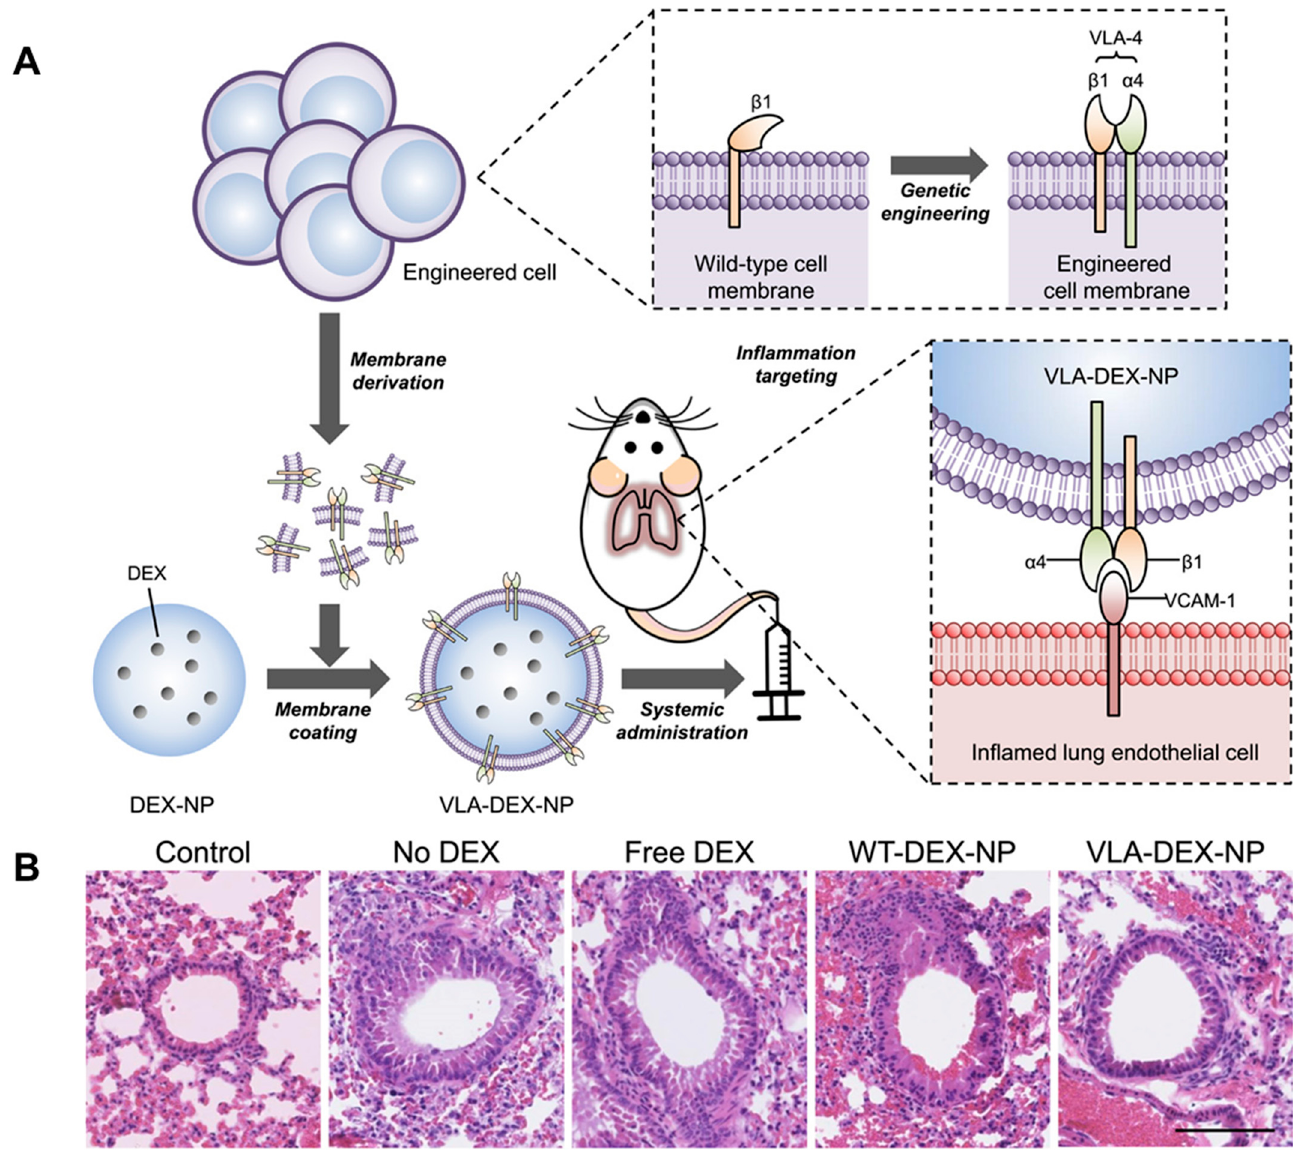
Figure 5. ( A ) Schematic illustration of genetically engineered cell membrane-coated nanoparticles for targeted drug delivery to inflamed lungs. ( B ) Mice were challenged with bacterial lipopolysaccharide and then treated with intravenous administration of VLA-DEX-NP in H&E lung histological sections (scale bar, 100 μ m). Reproduced with permission from [166].